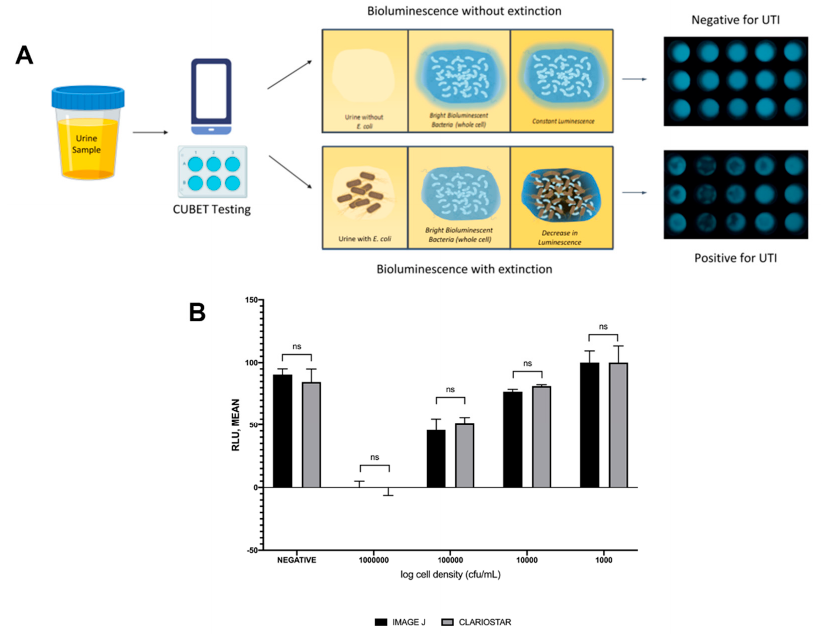
Figure 5. ( A ) Flow of urinary tract infection detection using cellphone-based UTI bioluminescence extinction technology (CUBET), ( B ) Comparison of the CUBET assay with a highly sensitive luminometer. (ns = not